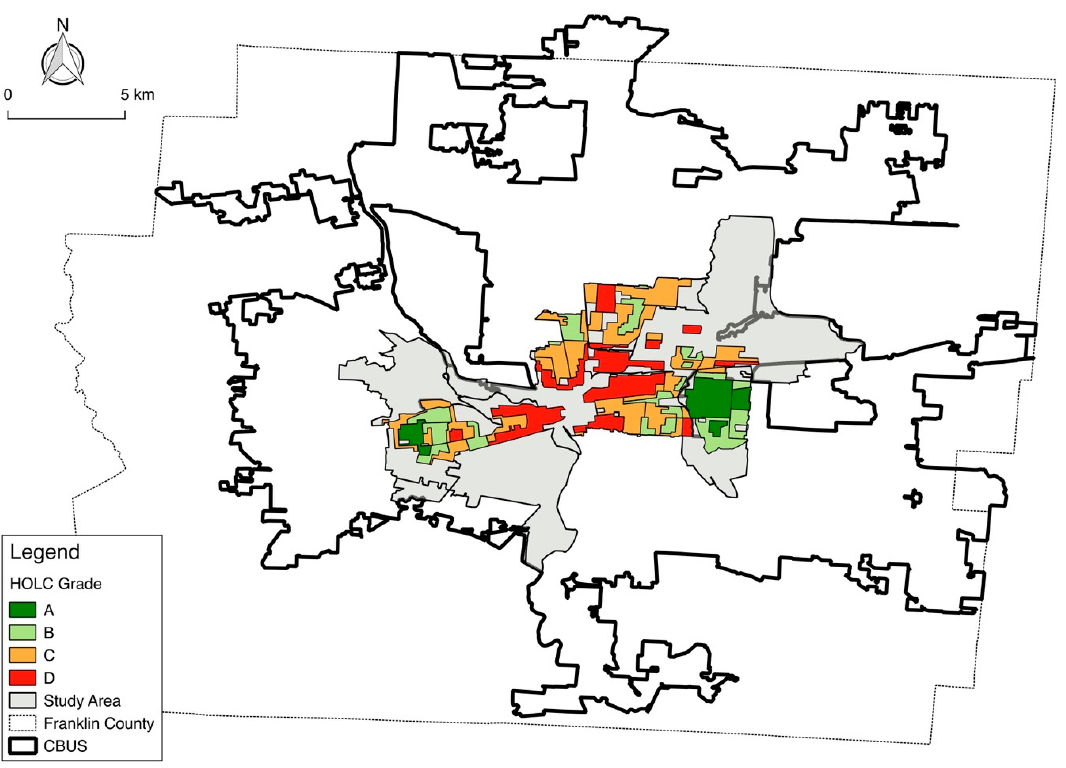
Figure 3. A Home-Owners’ Loan Corporation (HOLC) redlining map in Columbus, Ohio, in 1936. Note. CBUS: the boundary of the City of Columbus, Ohio. Source: Redlining Maps—Ohio Cities: Ohio State University Libraries: http://guides.osu.edu/maps-geospatial-data/maps/redlining/. Authors re- created.